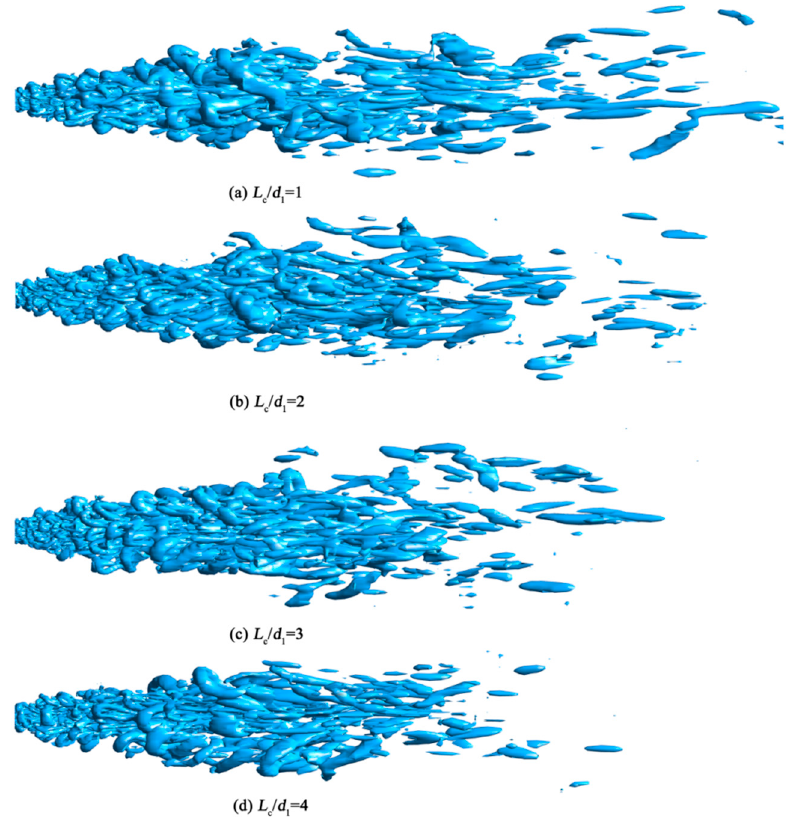
/ d = 8, L / d = 1, 2, 3, c c 1 1